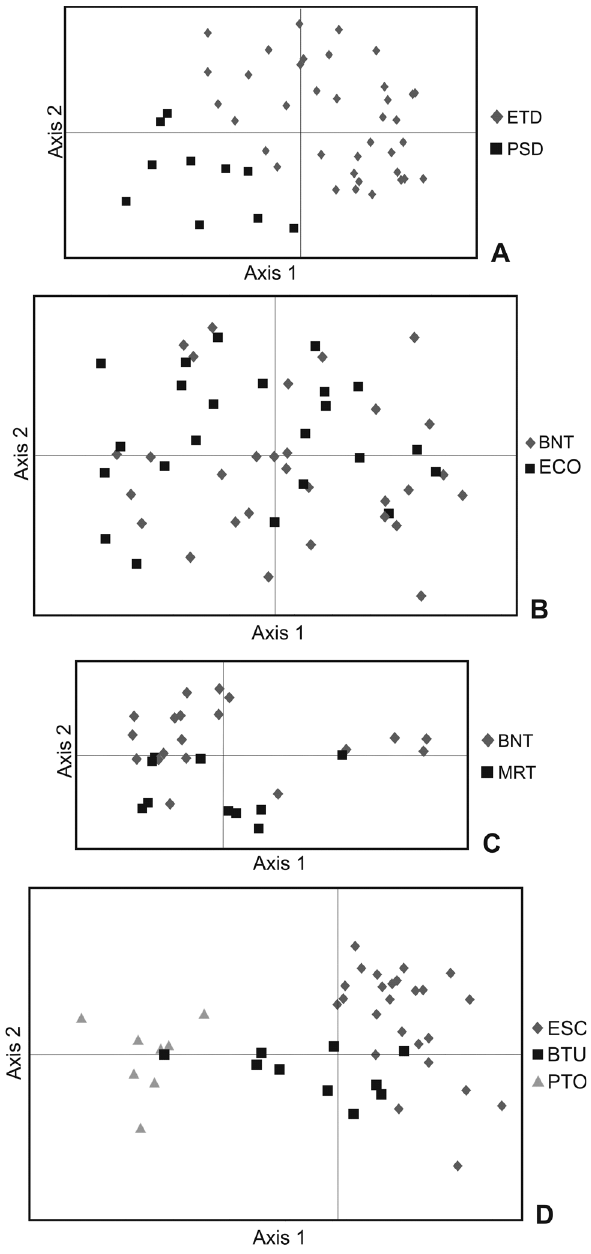
Figure 3 - Ordination of individual microsatellite profiles of four Calibrachoa species in a principal coordinate analysis (PCoA) with the first two vectors per species: (A) C. eglandulata ; (B) C. sendtneriana ; (C) C. serrulata ; and (D) C. spathulata . Individuals are labeled according to the